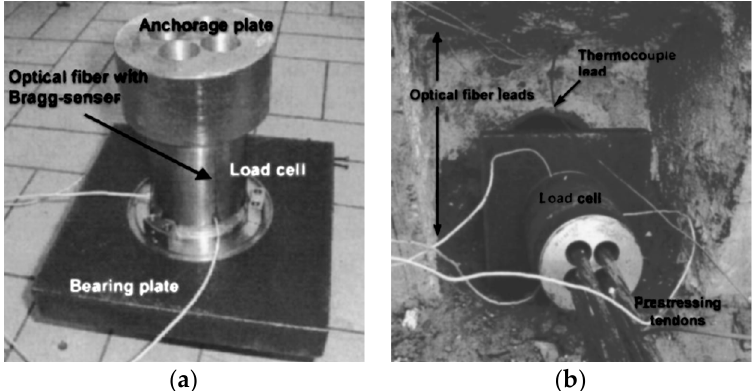
Figure 11. ( a ) The FBG instrumented load cell; ( b ) the load cell is placed in the quay wall [45].